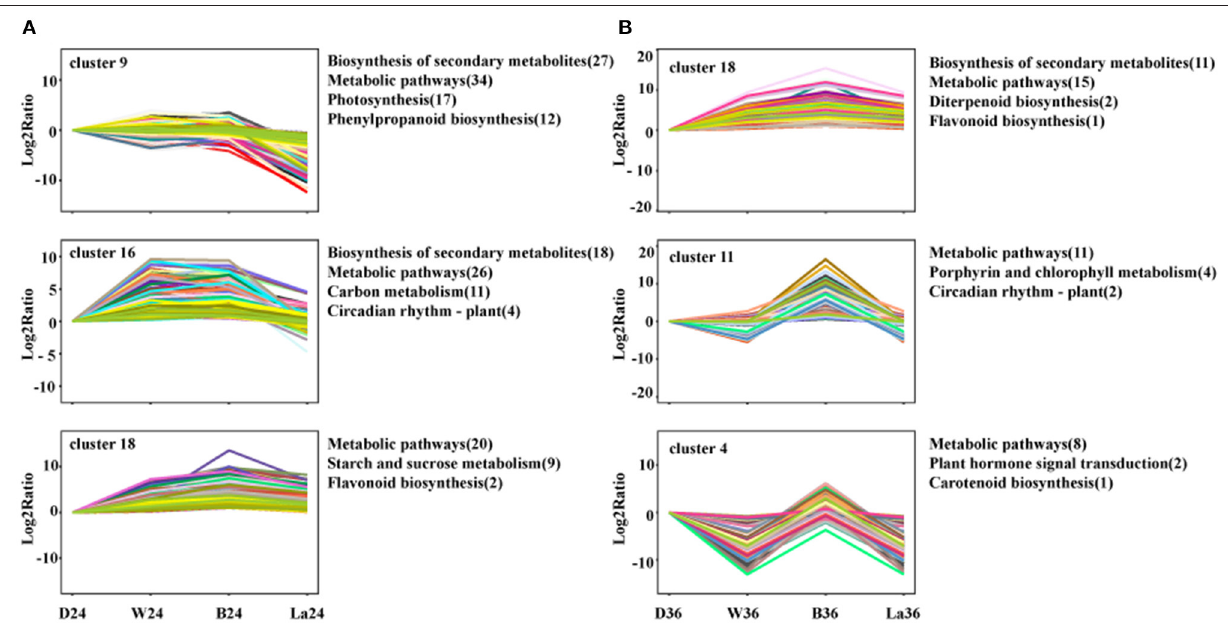
were obtained, such as cyanidin, pelargonidin,